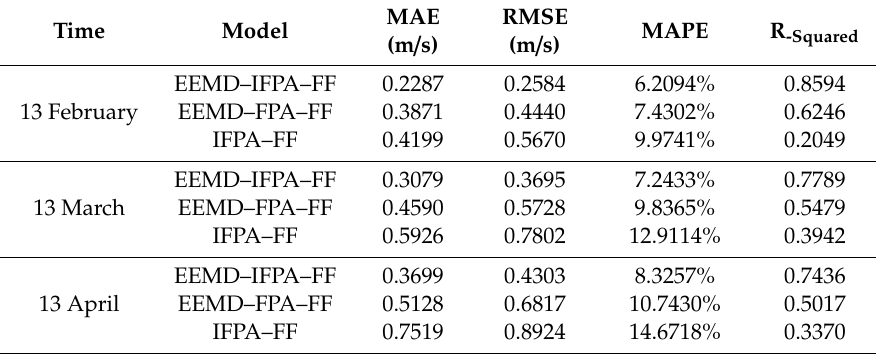
Table 8. Error comparison of testing samples with existing